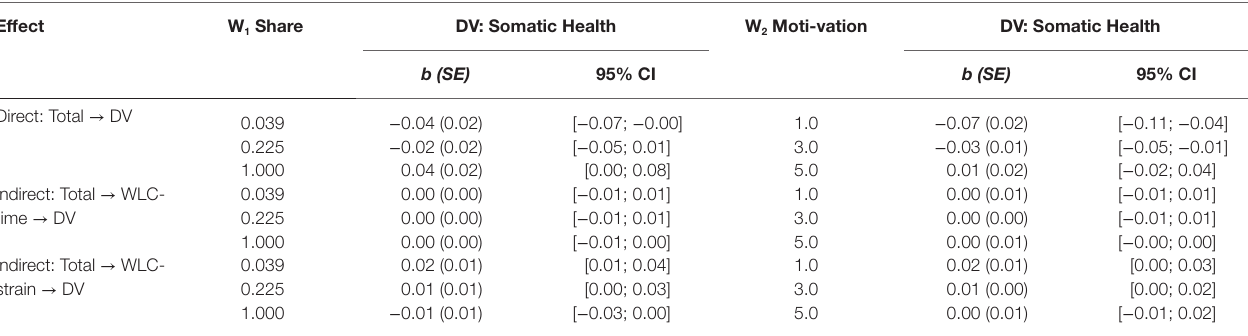
TABLE 7 | Conditional direct and indirect effects of the moderated mediation analyses for W 1 share and W 2 motivation.